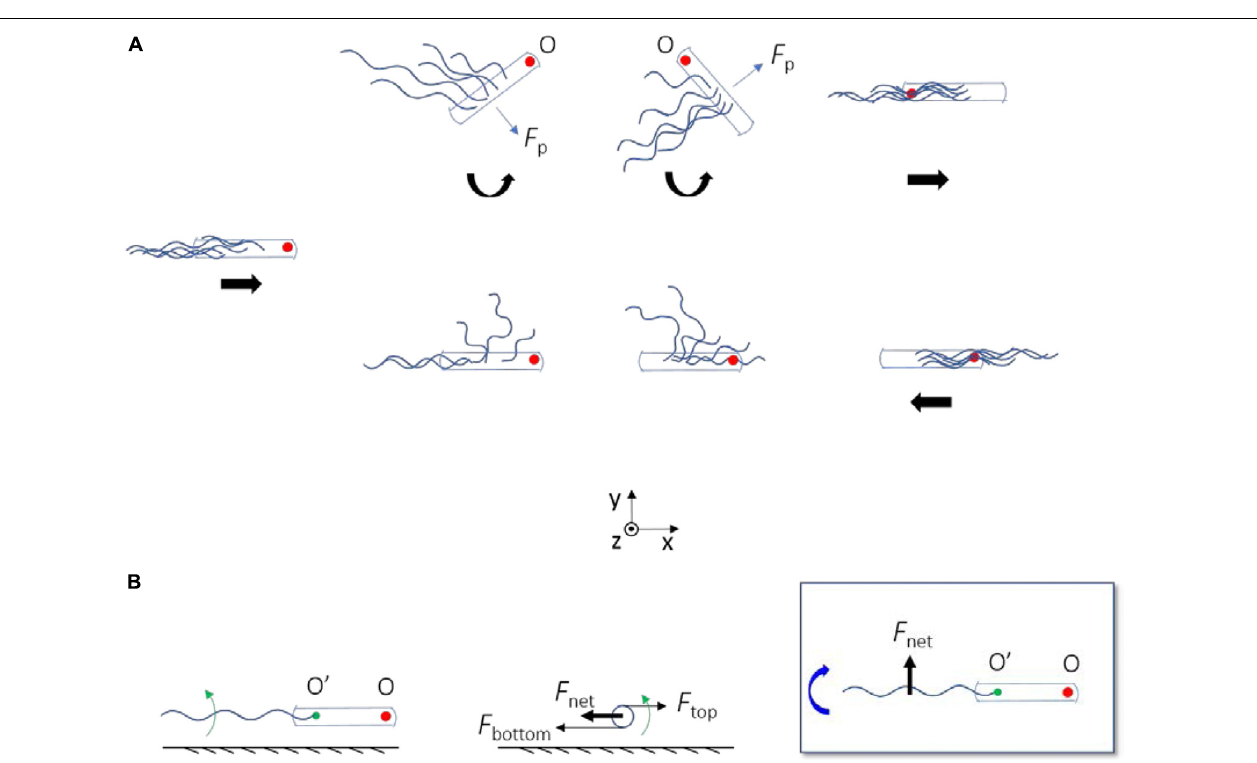
FIGURE 6 | (A) A schematic diagram depicting the two ways by which (cid:49) cheY mutant can reverse without motor switching. The straight thick arrows below the cells indicate the velocity direction of the bacterium, and the curved ones represent the direction of rotation of the cell body about the pinned head (O). When there is no arrow, the bacterium is at rest. The red filled circle marks the position of the initial head. In both cases, the flagella roll CW about their ends on the cell body. The flagella generate a propulsion force on the cell body ( F p ). When there is spatial freedom for the cell body to rotate, F p leads to a z -torque on the cell body that makes it rotate CCW about O (top panels); otherwise the cell body remain fixed (bottom panels). (B) Physical mechanism for CW rolling of the flagella near surface. Left, center, and right panels are the side, rear, and top views, respectively. Green arrows represent the CCW rotation of the flagellum about its axis (viewed from rear). The green filled circle marks the end of the filament on the cell body (O’). F net with O’ as the instantaneous fixed origin leads to a negative z -torque on the flagellum, which makes it roll CW about O’ (as denoted by the curved thick blue arrow).